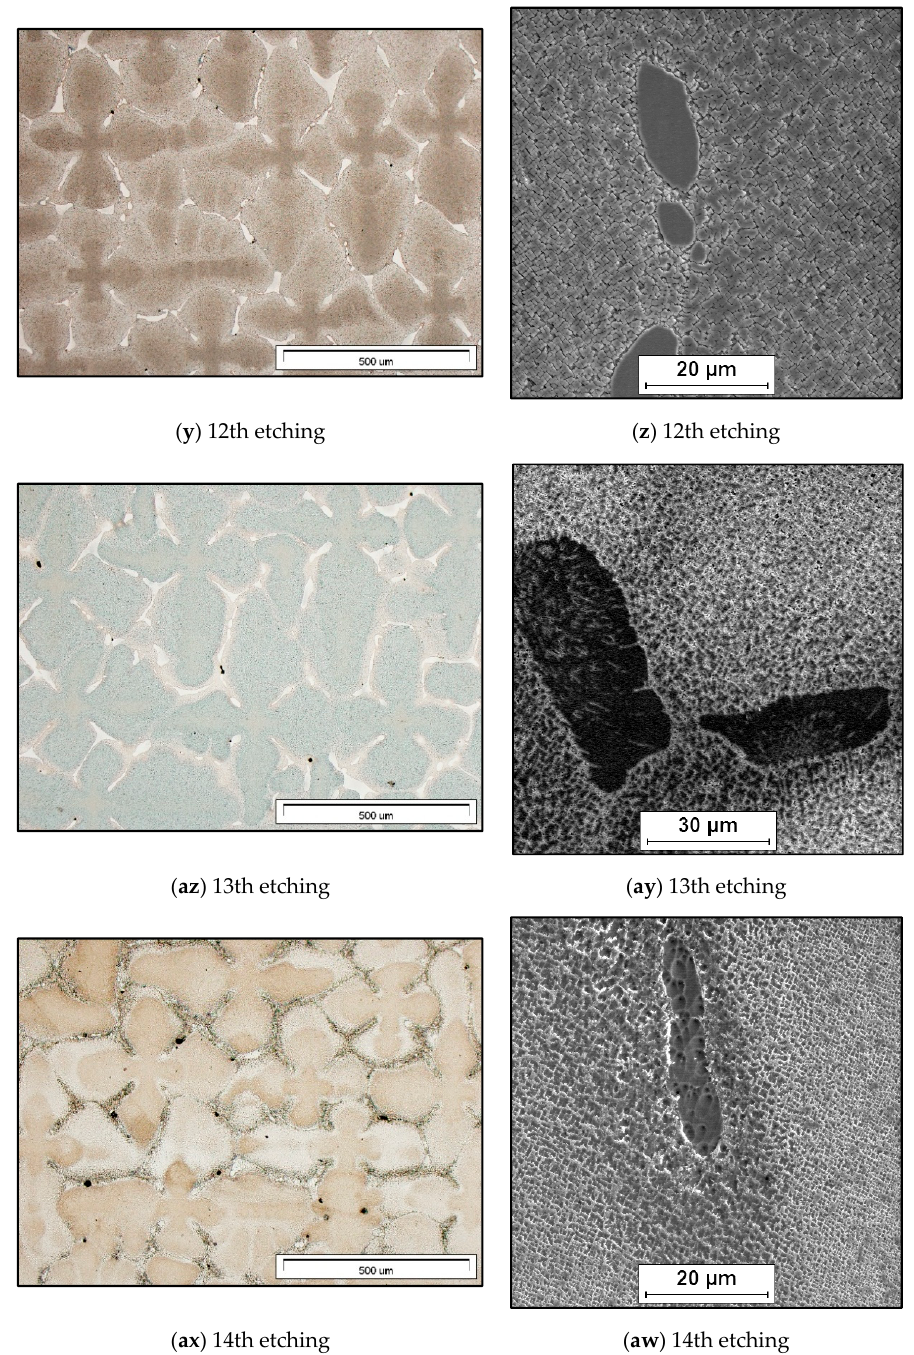
Figure 2. The cross-section microstructure of the as-cast single-crystalline CMSX-4 superalloy: a , c , e , g , i , k , m , o , r , t , w , y , az , ax (LM, BF); b , d , f , h , j , l , n , p , s , u , x , z , ay , aw (SEM, SE).